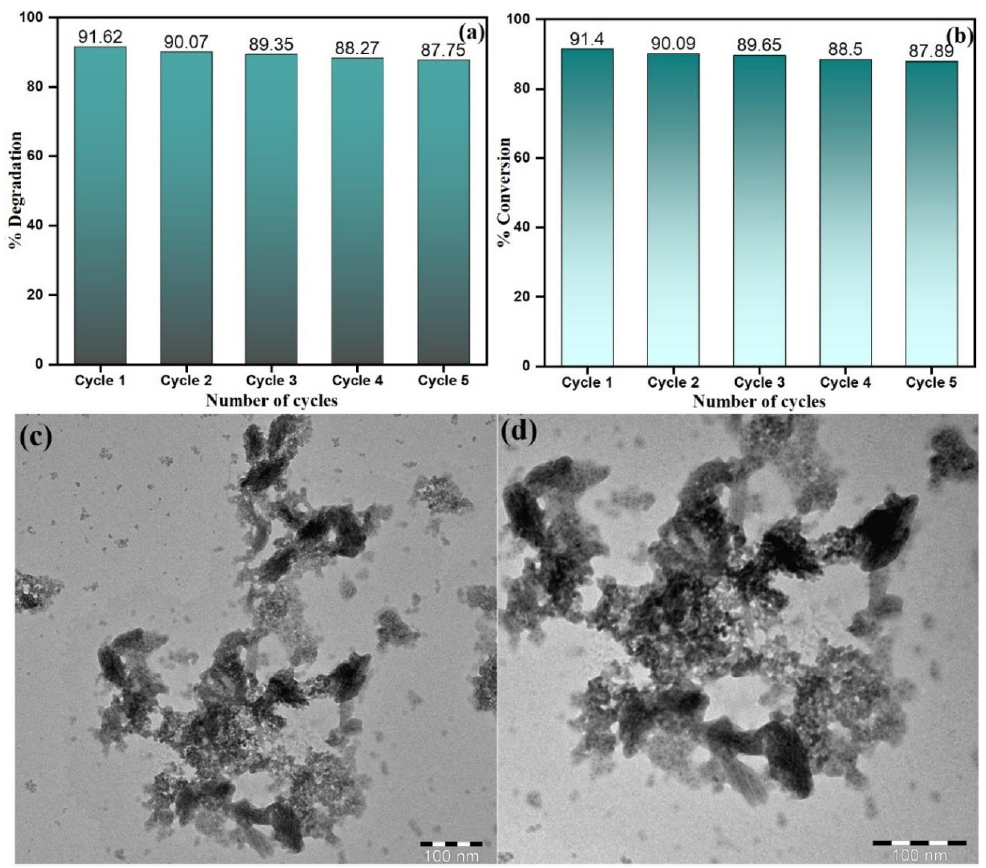
Figure 14. Catalytic recyclability of PdNPs for ( a ) CR dye degradation, ( b ) catalytic reduction of 4-NP. TEM image after five cycles of use for ( c ) CR dye degradation and ( d ) catalytic reduction of 4-NP.